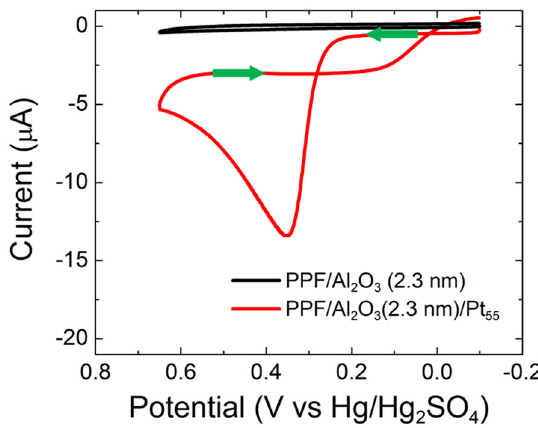
Figure 5. CVs obtained for CO electrooxidation on PPF/Al 2 O 3 (2.3 nm) and PPF/Al 2 O 3 (2.3 nm)/Pt 55 electrodes. The solutions contained aqueous, CO-saturated 0.10 M HClO 4 . The electrode potential was scanned between –0.10 and 0.65 V at 0.050 V/s. The experiments were carried out in triplicate for each electrode configuration using independently prepared electrodes to ensure reproducibility.